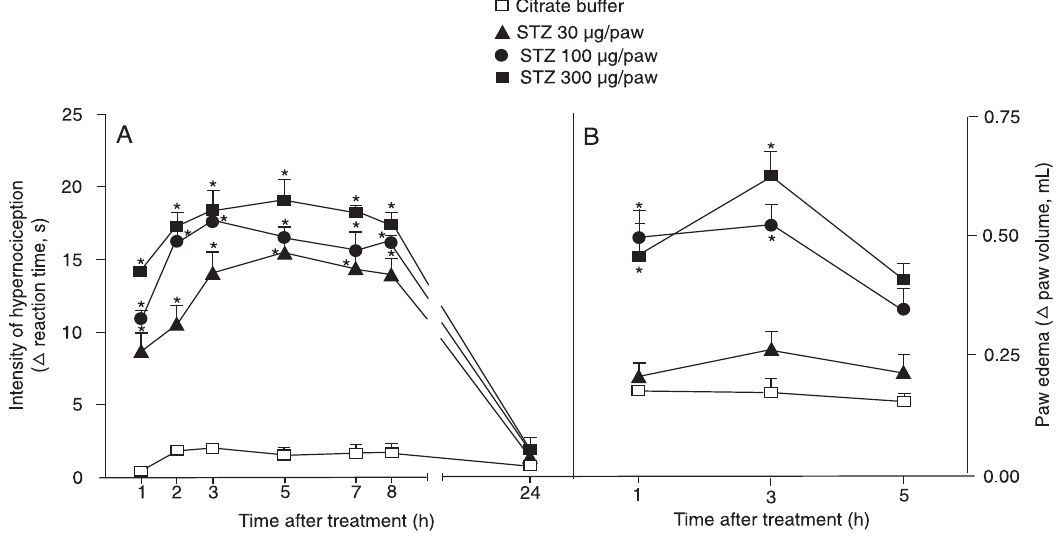
Figure 4. Mechanical hypernociception and paw edema induced by local ipl administration of streptozotocin (STZ). Mechanical hypernociception (panel A) and paw edema (panel B) were evaluated at the indicated hours after ipl administration of vehicle (control group; citrate buffer, 10 mM, pH 7.0; 100 μ L/paw) or STZ (30, 100, or 300 μ g/paw). Data are reported as means ± SEM for groups of 6 rats. *P < 0.05 compared to citrate buffer-treated rats (ANOVA followed by the Bonferroni